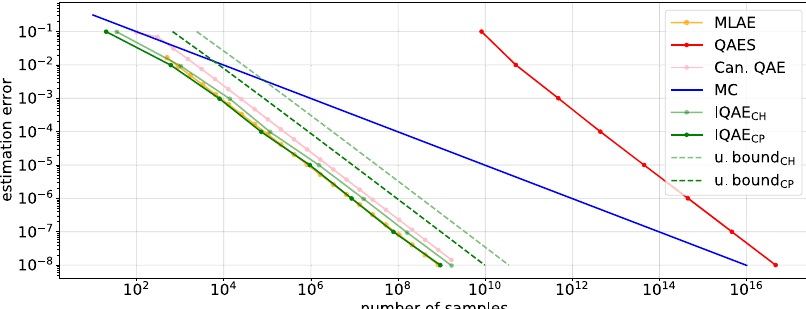
Fig. 3 Comparison of QAE variants. The resulting estimation error for a = 1/2 and 95% con fi dence level with respect to the required total number of oracle queries. We also include theoretical upper bounds for two versions of IQAE (CH = Chernoff-Hoeffding, CP = Clopper- Pearson). Note that QAES provides a relative error estimate, while the other algorithms return an absolute error estimate. For MLAE and canonical QAE we use the likelihood ratio con fi dence intervals. For MLAE we count the number of oracle calls for the largest power of Q operator, which corresponds to the parallel execution of the algorithm. For IQAE, MLAE, and canonical QAE we used N shots = 100.